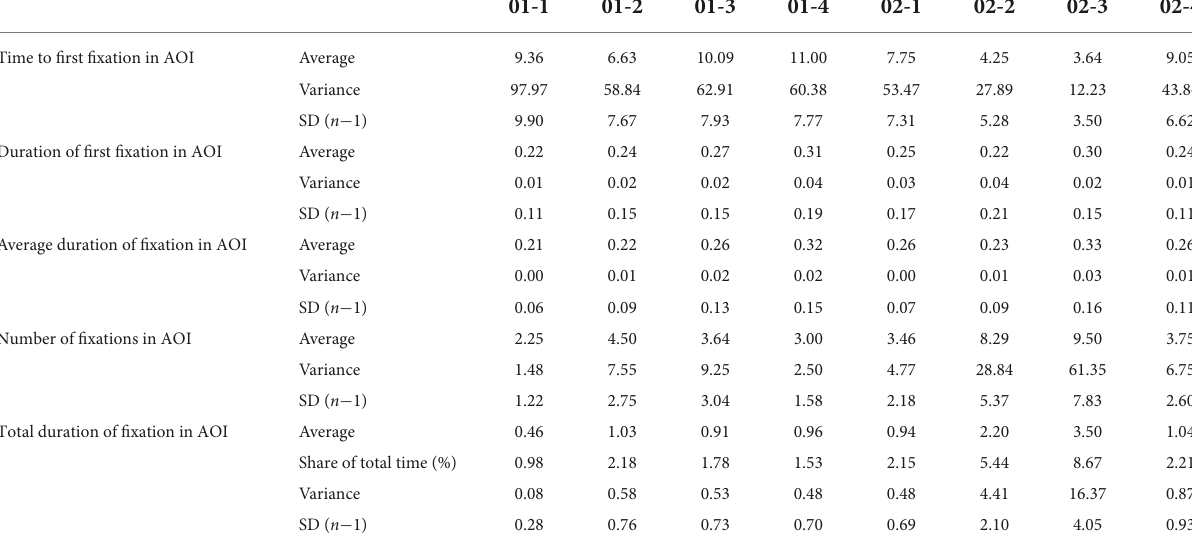
TABLE 2 Eye movement statistics of subjects from AOI 01-1 to AOI 02-4.